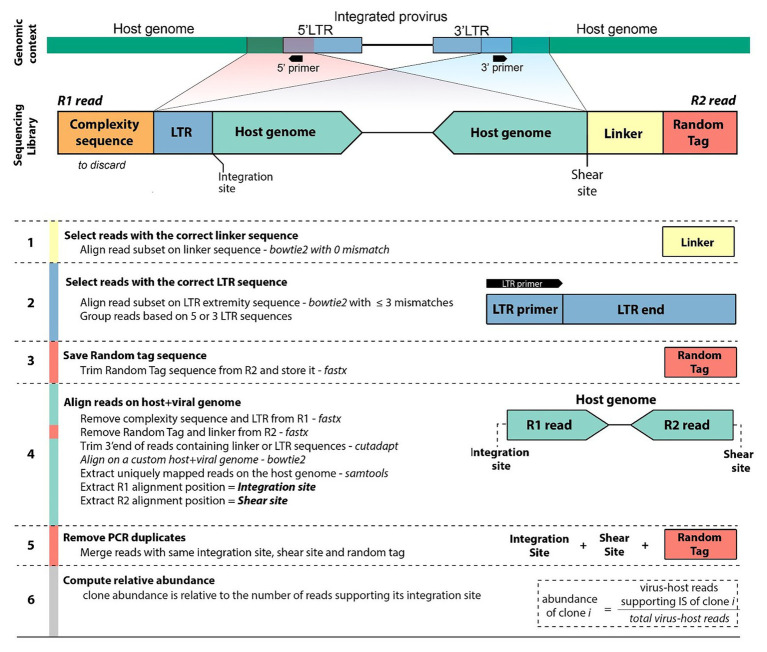
Workflow diagram. Sequencing of clonality libraries produces pairs of 150-bp reads. Read 1 (R1) contains a complexity sequence, a partial LTR sequence from the LTR primer to the LTR extremity (LTR), and the flanking host genomic sequence defining the integration site. Read 2 (R2) contains a random tag, the linker sequence, and the host genomic sequence defining the shear site. Read pairs originate from either the 5'LTR or the 3'LTR (shown here is the 3'LTR configuration). The pipeline identifies the integration site, shear site, and random tag of each pair of reads (see Materials and Methods section). Reads sharing the same integration site are grouped and, the abundance of the corresponding clone is computed after removal of PCR duplicates.